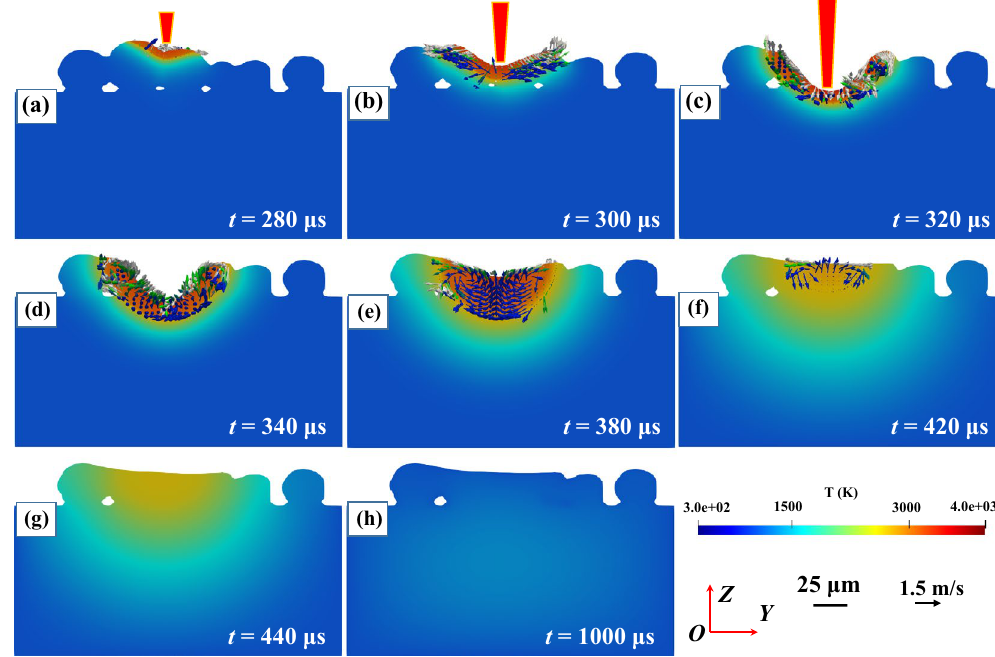
Figure 11 Serial cross-sections of LPBF tracks at 150